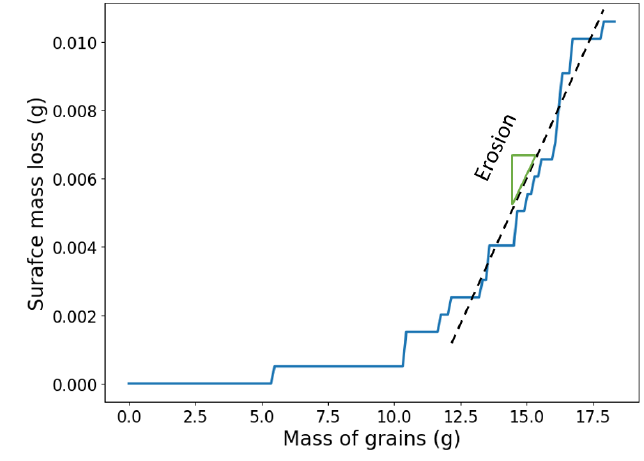
Figure 8. Surface mass loss growth in terms of the mass of the grains for impact angle of 15° and one surface sample. Erosion is calculated as the slope of the dashed line fitted to the steady part of the mass loss